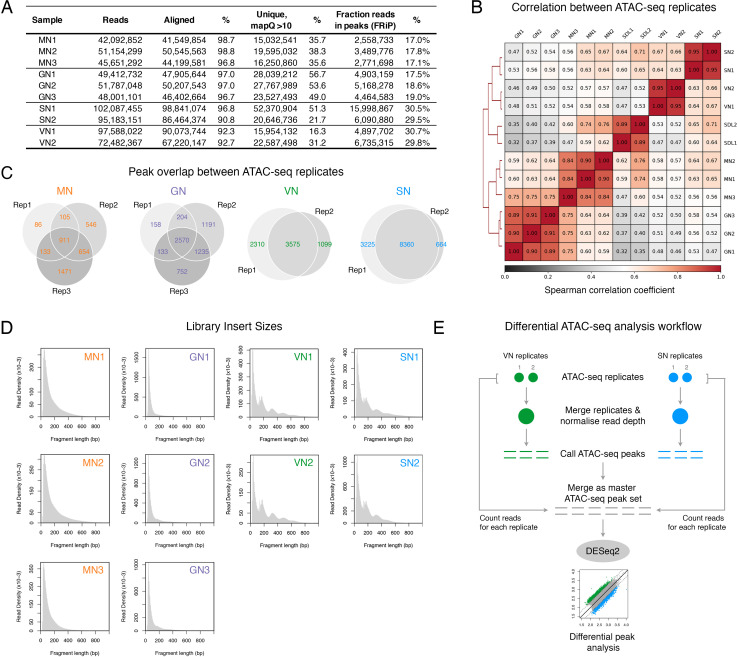
ATAC-seq profiling performed in this study.(A) Table summarising the statistics of the ATAC-seq libraries sequenced in this study. (B) Spearman cross-correlation matrix of the pollen ATAC-seq data sets alongside published profiles from Arabidopsis seedlings (Lu et al., 2017). (C) Pie chart summarising the overlap of peaks among replicates of the pollen ATAC-seq profiles. (D) Fragment size distribution of each pollen ATAC-seq library. (E) Schematic diagram summarising the analysis workflow for the differential peak analysis of the pollen ATAC-seq profiles.